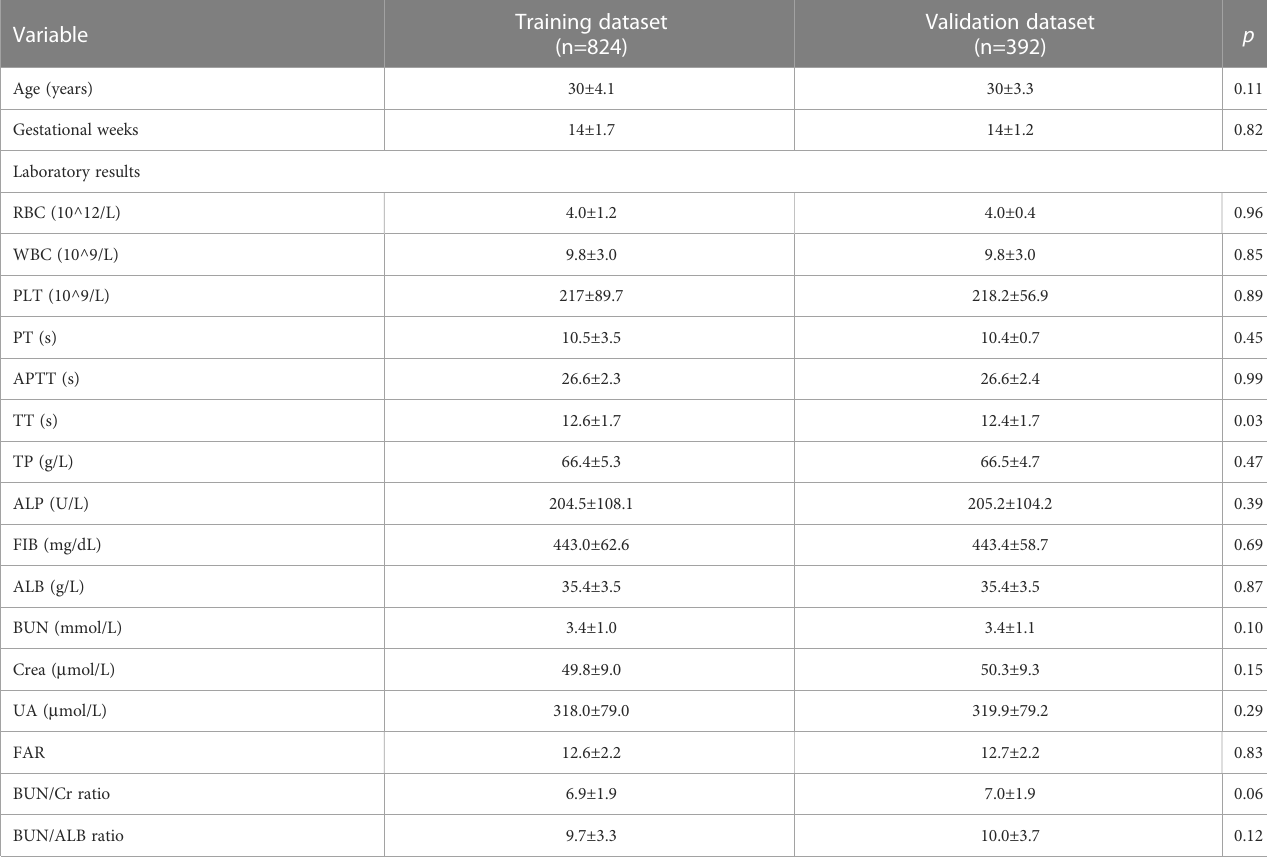
TABLE 1 A summary of the variables grouped by training and validation dataset in this study.